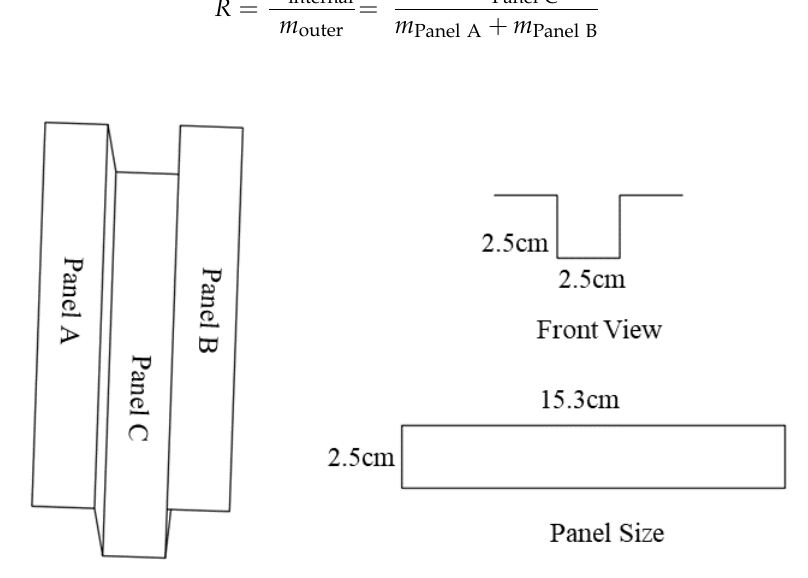
Figure 4. Specially designed panel for characterization of Faraday cage effect.